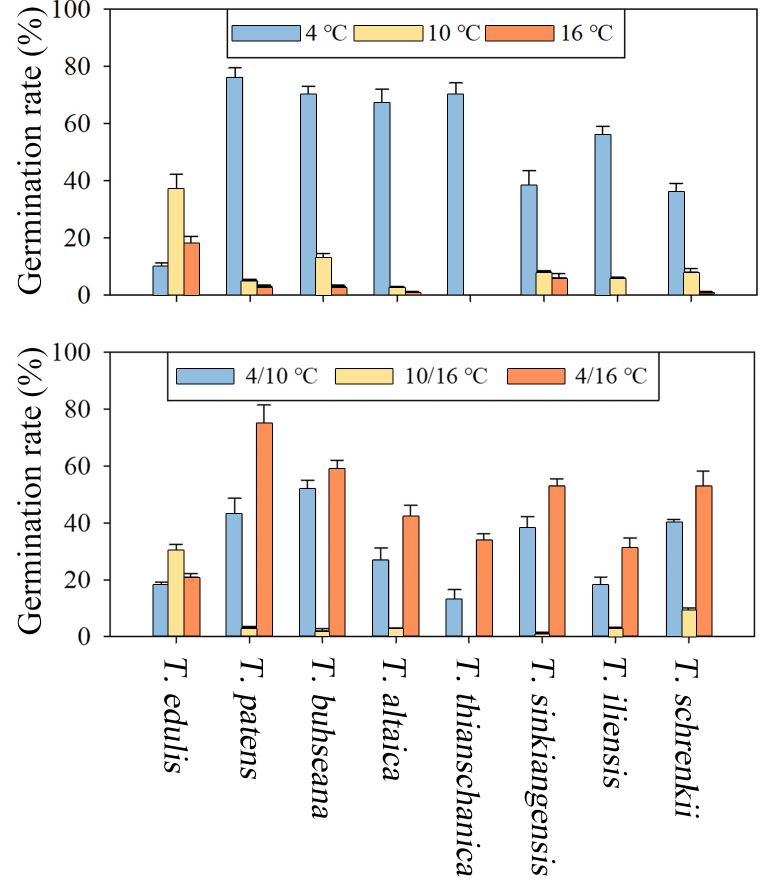
Figure 3. Effects of temperatures on seed germination of eight wild Tulipa species native to China.